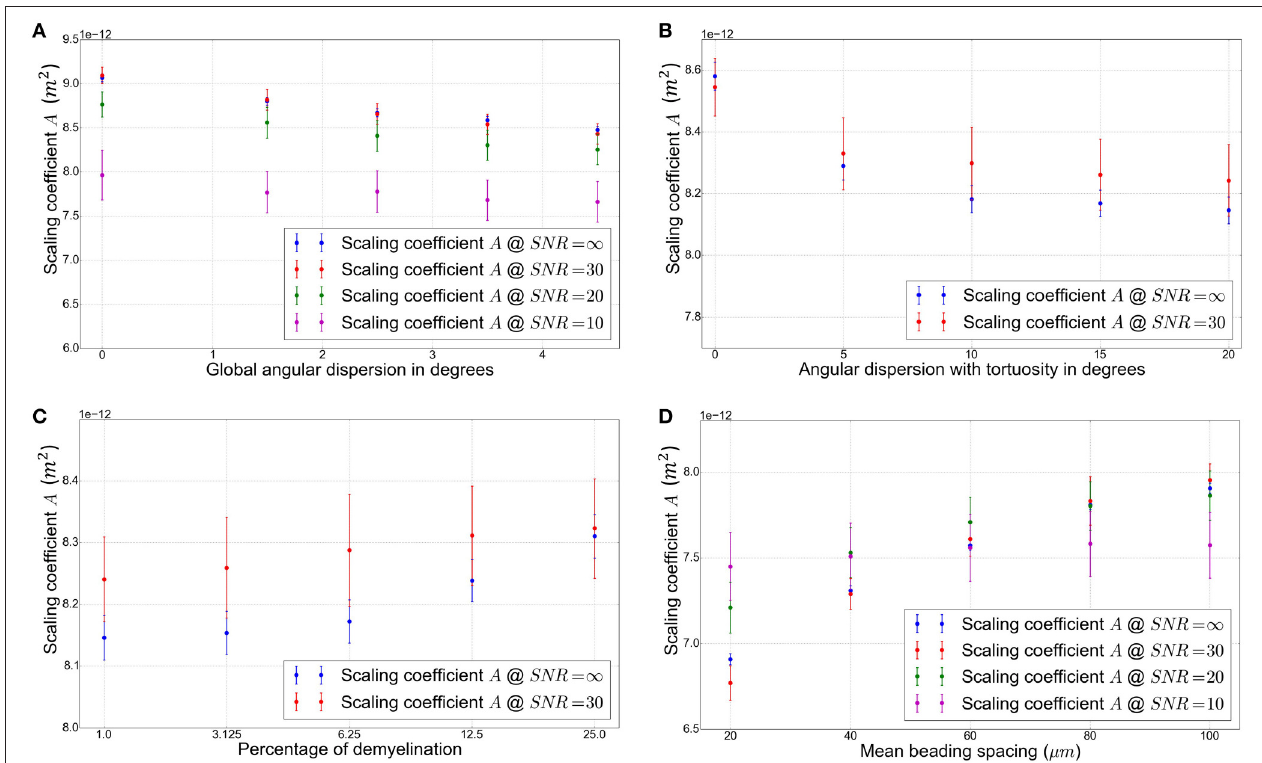
FIGURE 10 | (A) Value of the scaling coefficient A in m 2 plotted against the global angular dispersion. The simulations were performed in variants of configuration C2 by varying the global angular dispersion value (see Table 2 ). (B) Value of the scaling coefficient A plotted against the angular dispersion. The simulations were performed in variants of configuration C3 by varying the local tortuosity value (see Table 2 ). (C) Value of the scaling coefficient A plotted against the percentage of demyelination. The simulations were performed in variants of configuration C4 by varying the percentage of demyelination, directly related to the width of Ranvier nodes (see Table 2 ). (D) Value of the scaling coefficient A plotted against the mean beading spacing. The simulations were performed in variants of configuration C5 by varying the value of the mean beading spacing (see Table 2 ). A bigger spacing yields to a lower beading